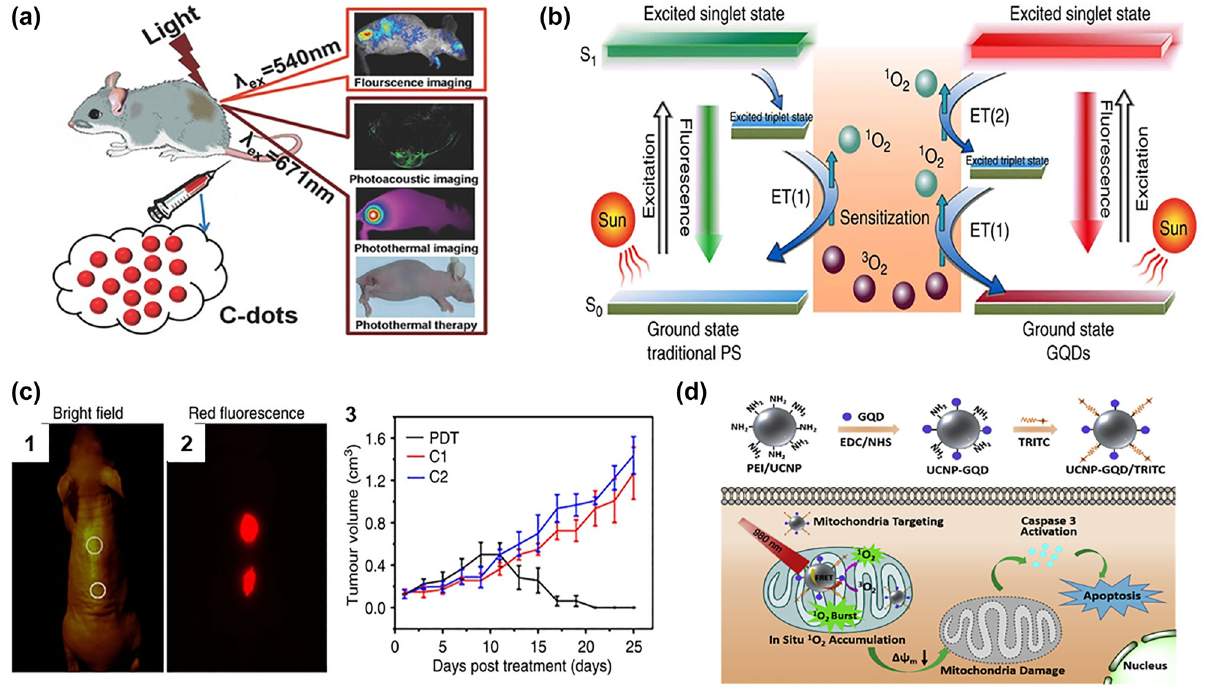
Figure 5: CQDs for phototherapy: (a) Red-emission CQDs for imaging and PTT, Copyright 2022 John Wiley and Sons. [130], (b & c) CQDs for PDT [133], Copyright 2022 Ge, J. et al. (d) CQDs for NIR-II mitochondria specific PDT [134], Copyright 2022 Elsevier publishing